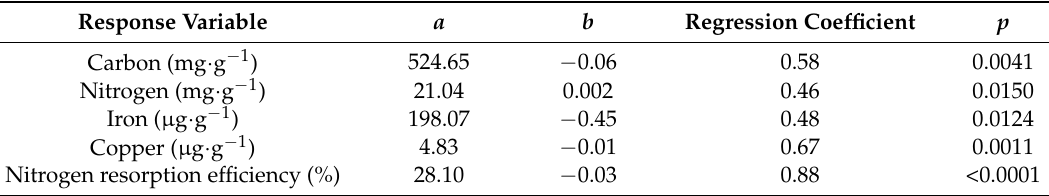
Table 2. Linear regression parameters of senesced leaf element response variables with Yap Cycas micronesica tree height as the independent variable. Variable = a + b × height.